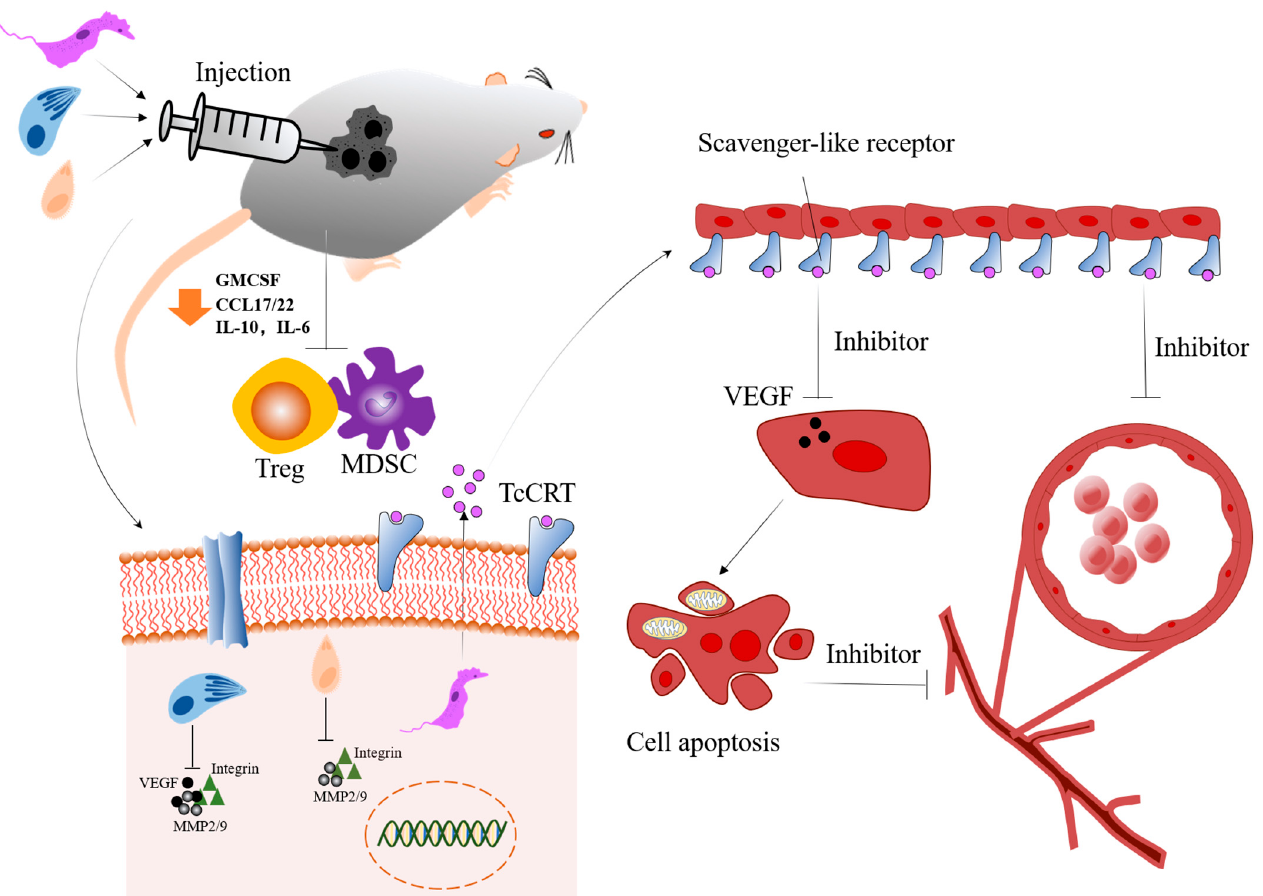
Figure 2. Protozoans modulate the tumor immune microenvironment and inhibit angiogenesis. Leishmania , Neospora caninum and Toxoplasma gondii could downregulate some cytokines (GMCSF, CCL17/22, IL-10 or IL-6) to inhibit Treg and MDSC; besides, these protozoans also could inhibit angiogenesis through suppressing the level of angiogenic factor (VEGF, MMP2/9 or integrin). Among these, the scavenger-like receptor could recognize TcCRT secreted by Trypanosoma cruzi , and it could inhibit VEGF to induce cell apoptosis. Abbreviations: MDSC: myeloid-derived immunosuppressive cell; Treg: regulatory T cells; GMCSF: Granulocyte-Macrophage Colony-Stimulating Factor human; CCL17/22: C-C class chemokines 17/22; IL-10: Interleukin 10; IL-6: Interleukin 6; VEGF: vascular endothelial growth factor; MMP2/9: matrix metallopeptidase 2/9; TcCRT: Trypanosoma cruzi calreticulin.